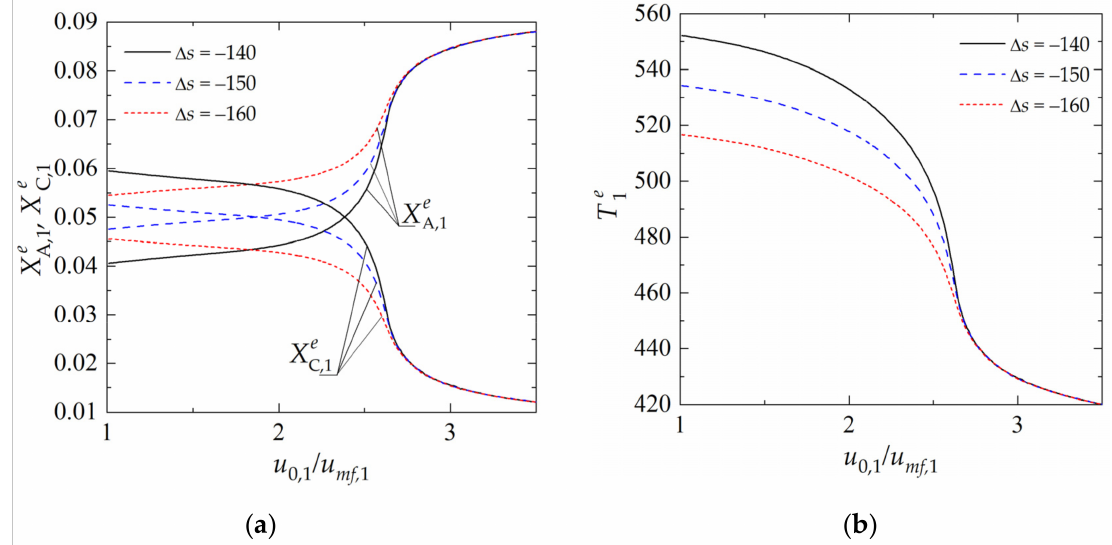
Figure 4. Dependence of state variables in the reactor on the fluidization ratio u 0,1 / u mf ,1 for different values of ∆ s : ( a ) dimensionless concentration of components A and C in the emulsion (dense) zone; ( b ) temperature of the emulsion zone. (Calculations performed with E ads = 3 × 10 4 kJ · kmol − 1 , u 0,2 / u mf ,2 = 2, τ p ,1 = τ p ,2 = 600 s and T f, 2 = 400 K; all values of ∆ s in the legend are expressed in kJ · kmol − 1 · K − 1